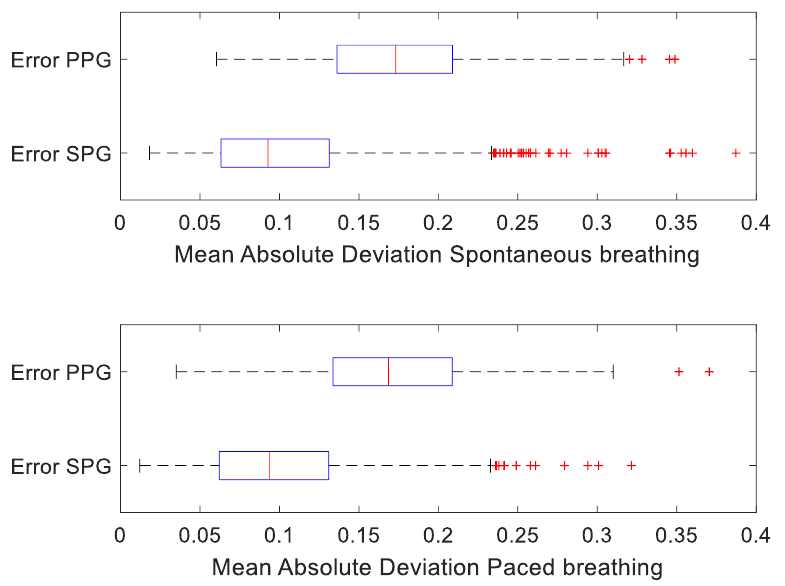
Figure 6. MAD beat-averaged of fiAP vs. PPG and fiAP vs. SPG, differentiating between episodes of spontaneous breathing and paced breathing.